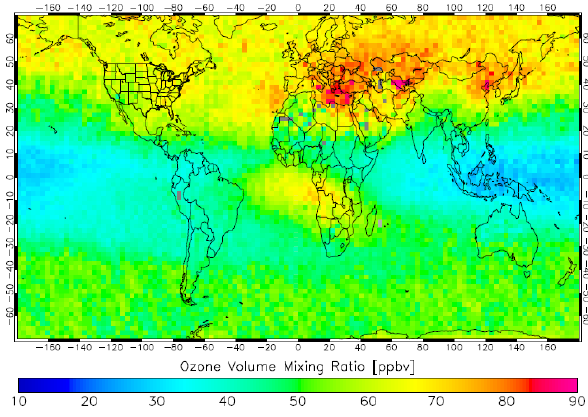
Figure 1. Seasonal average (June-July-August) of tropospheric ozone concentrations at 464 hPa as observed by TES between 2005 and 2010 averaged on a 3˚ × 2˚ (longitude × latitude) grid. The effect of the variable MOZART a priori has been removed by reprocessing the TES retrievals with one global and annual mean (MOZART) a priori O 3 profile following the method by Zhang et al. (2006). TES retrievals with residual clouds and errors have been excluded following the standard TES quality flags, leaving typically 50 data points in each grid cell.